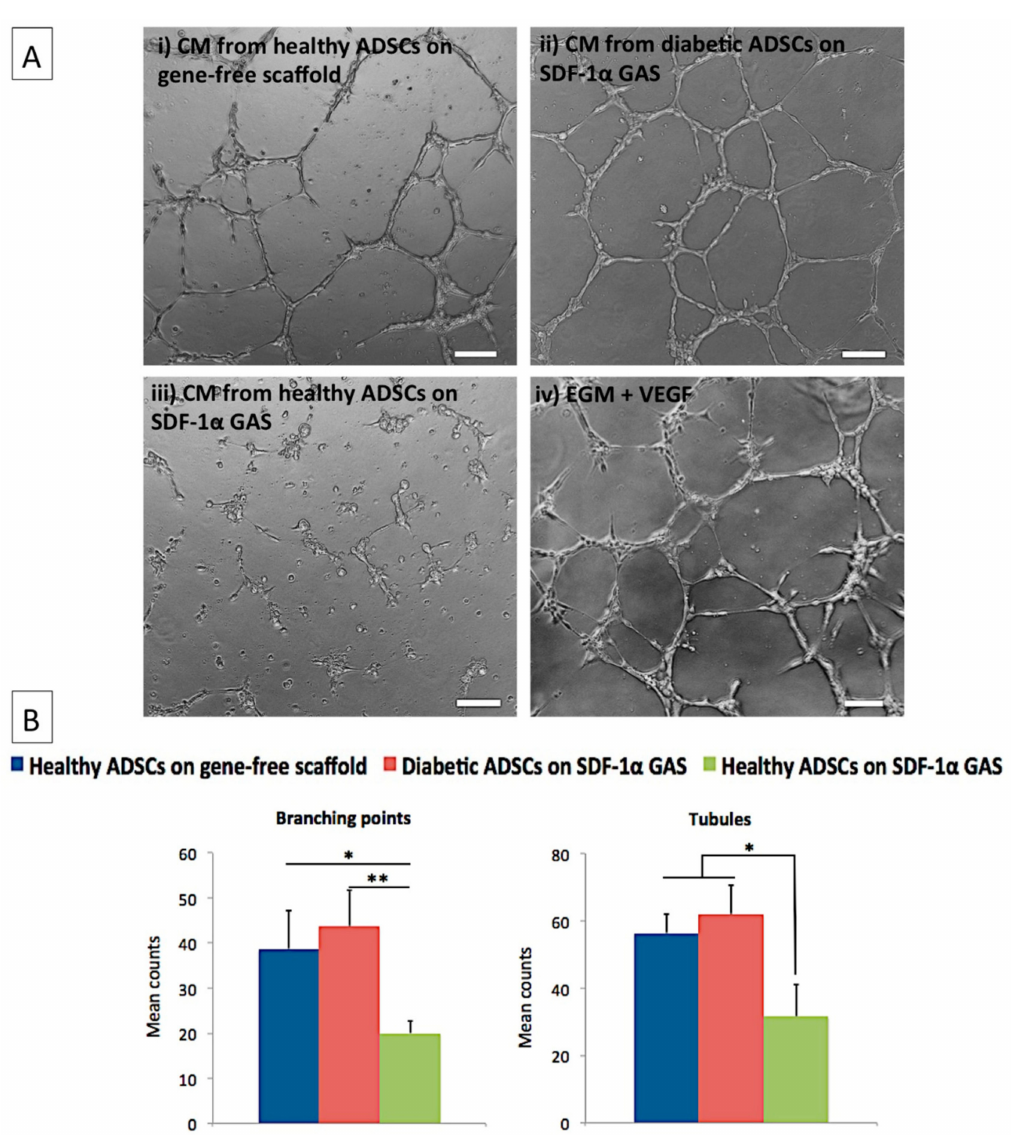
Figure 4. Pro-angiogenic impact of secreted factors from the transfected healthy and diabetic ADSCs. ( A ) The diabetic ADSCs on the SDF-1 α gene-activated scaffold induced the strongest pro-angiogenic response in human endothelial cells. ( B ) At 8 h post-exposure, CM from diabetic ADSCs significantly enhanced endothelial network branching ( p < 0.01) as well as tubules formation ( p < 0.05), compared to that induced by their healthy counterpart. EndoGro Media (EGM) + VEGF was used as reference medium to stimulate endothelial angiogenesis. Scale bar 100 µ m. * p < 0.01, ** p <